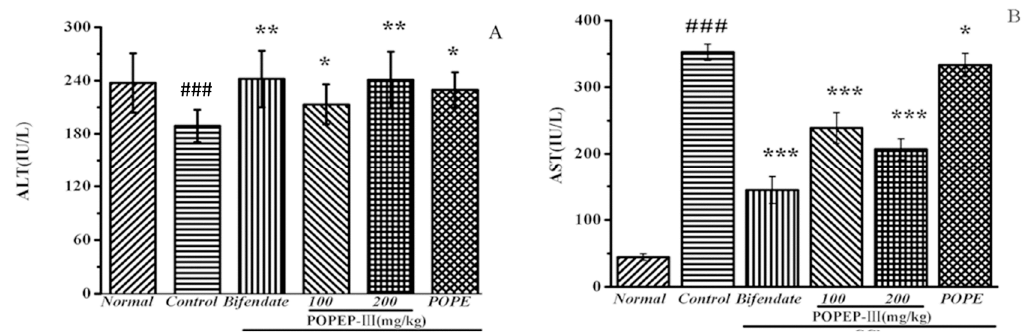
Figure 3. E ff ects of POPEP-III on the activities of serum ALT ( A ) and AST ( B ) in mice. Values are expressed as the mean values ± SD (n = 7): (###) p < 0.001 compared with the normal group; (***) p < 0.001, (**) p < 0.01, and (*) p < 0.05 compared with the CCl 4 -treated control group. Table 6. E ff ects of POPEP-III on the activities of serum ALT and AST in mice. ALT (IU /